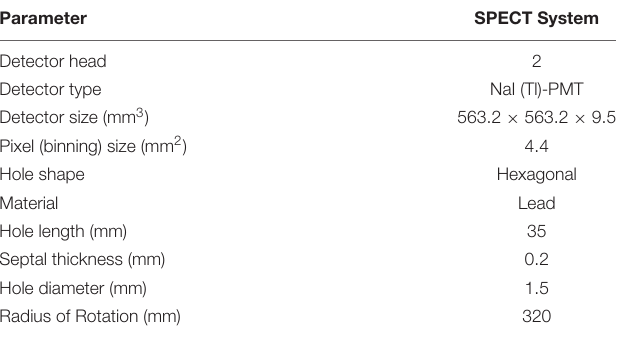
TABLE 1 | MC simulation parameters for SPECT system